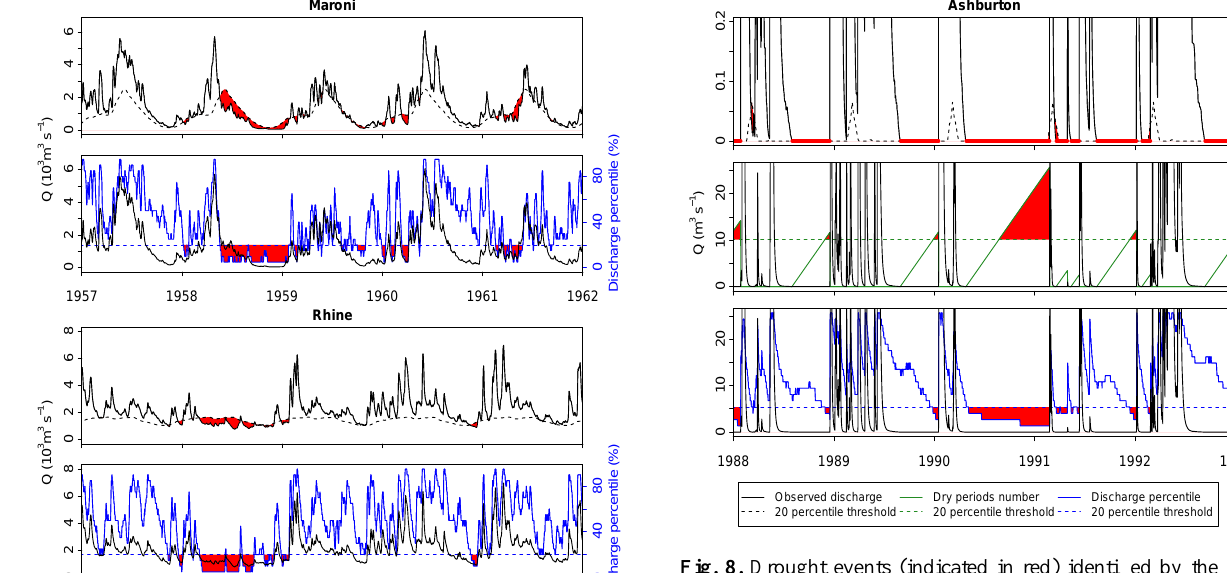
Fig. 8. Drought events (indicated in red) identified by the differ- ent methods for the Ashburton River. The upper panel gives the TLM. Discharge values are shown as solid black line. The dashed line is the calculated threshold (20th percentile). Please note only the low flow values are given on y-axis. The middle panel gives drought events calculated with the CDPM. The consecutive dry pe- riods are indicated by the green line, and droughts are identified if periods exceed the threshold (dashed green line). When combining these methods, the discharge is converted to percentile values (low- est panel, blue solid line). If the percentile value drops below or equals the 20% (dashed blue) line, the month is in drought. Table 2. Drought characteristics for the different rivers identified with the drought analysis